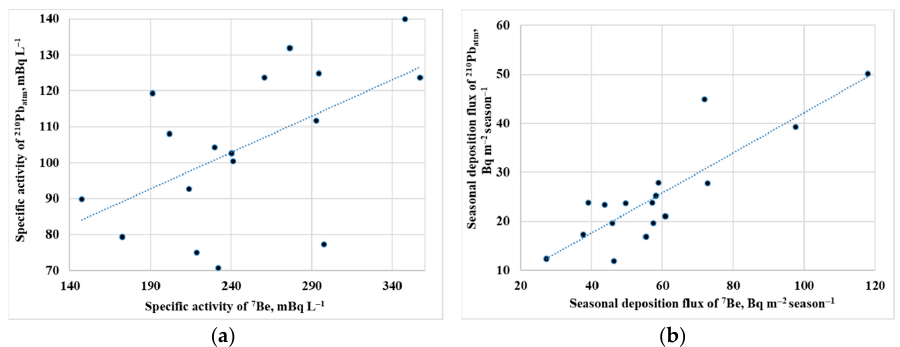
Figure 3. Correlation of ( a ) specific activities of 7 Be and ( b ) its seasonal deposition fluxes with 210 Pb atm in integrated snow samples at the time of sampling.